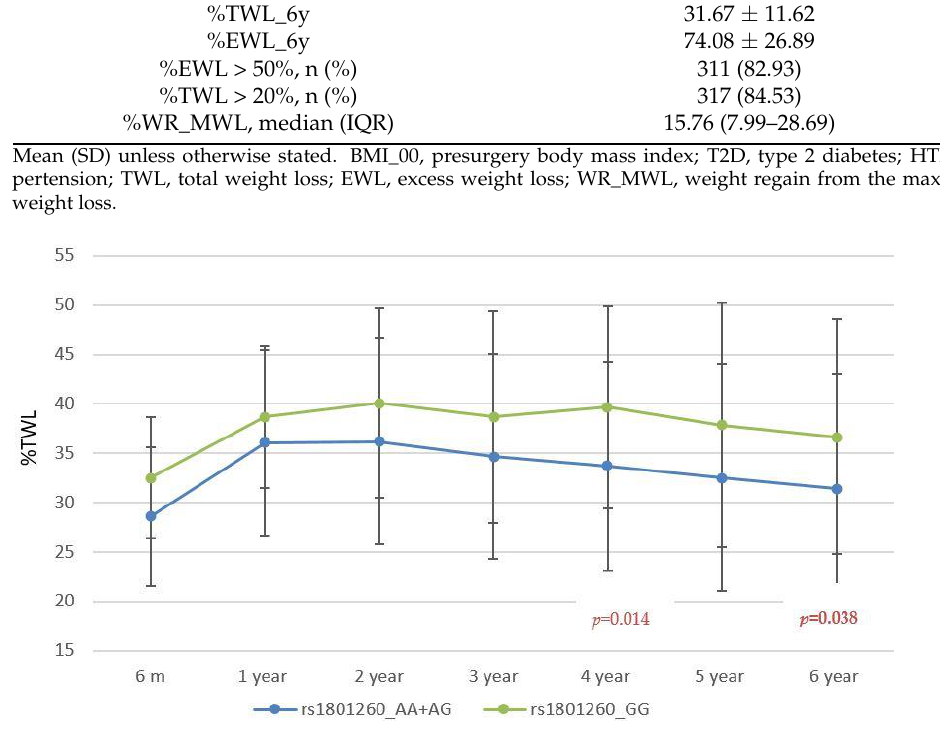
Figure 1. Mean %TWL in the follow up by rs1801260 genotypes.